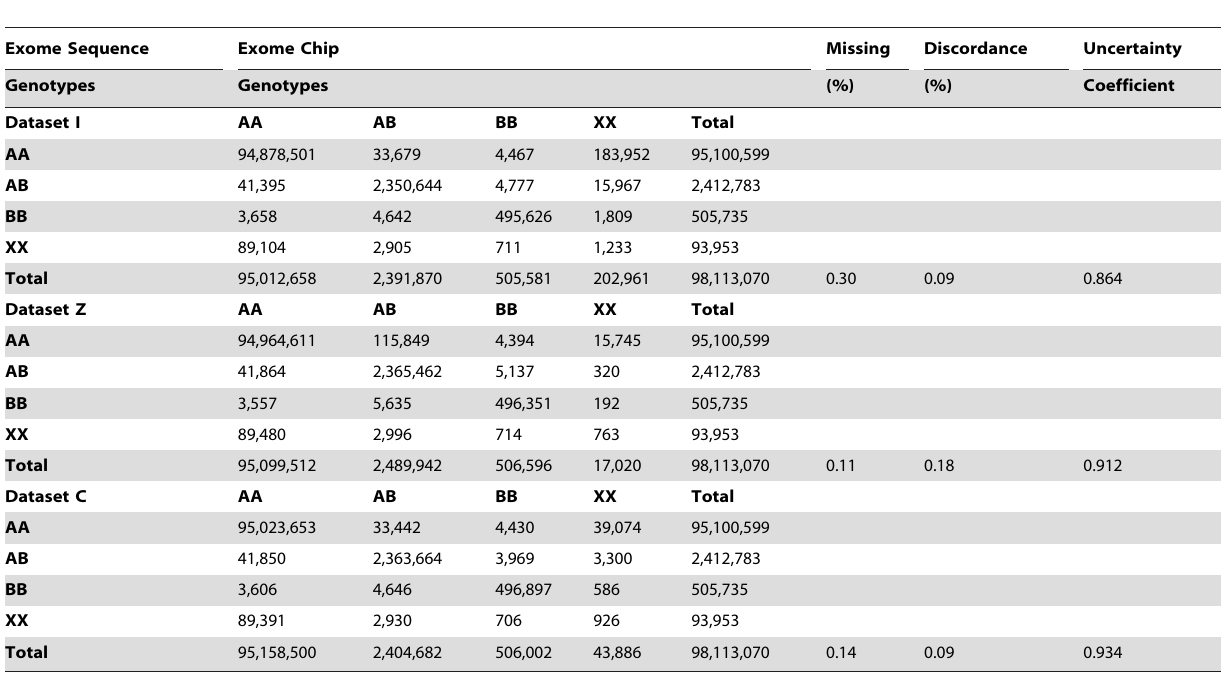
Table 2. Results of missing data, genotype discordance, uncertainty coefficients and frequencies of exome chip data ascertained by three calling methods and compared to exome sequence genotypes.